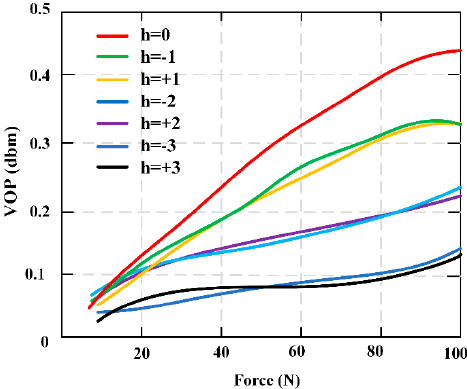
Figure 7. The varying values of output power (VOP) and the force condition of the artificial bone (AB) embedded magnetoelastic sensor (MES) in seven different positions.